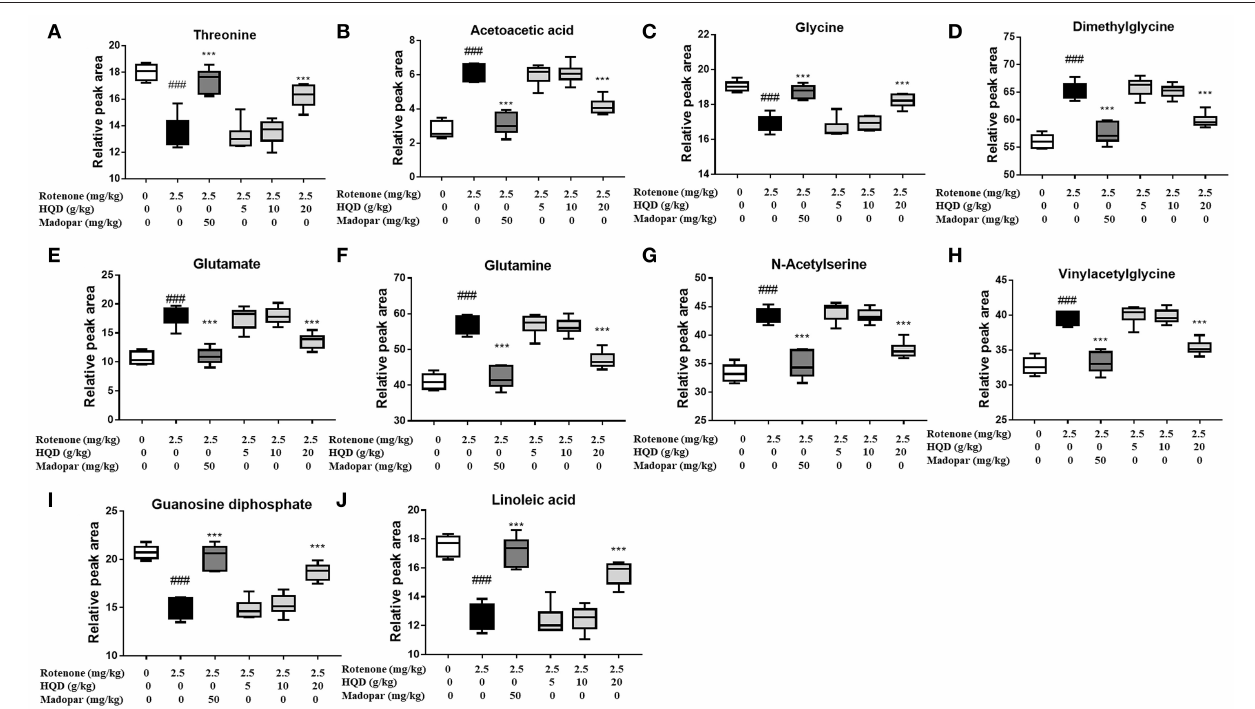
FIGURE 9 | Relative peak areas of the differential metabolites affected by HQD in rats with PD: (A) threonine; (B) acetoacetic acid; (C) glycine; (D) dimethylglycine; (E) glutamate; (F) glutamine; (G) N-acetylserine; (H) vinylacetylglycine; (I) guanosine diphosphate; (J) linoleic acid. ### P < 0.001 vs. control group; *** P < 0.001 vs. rotenone group ( n =